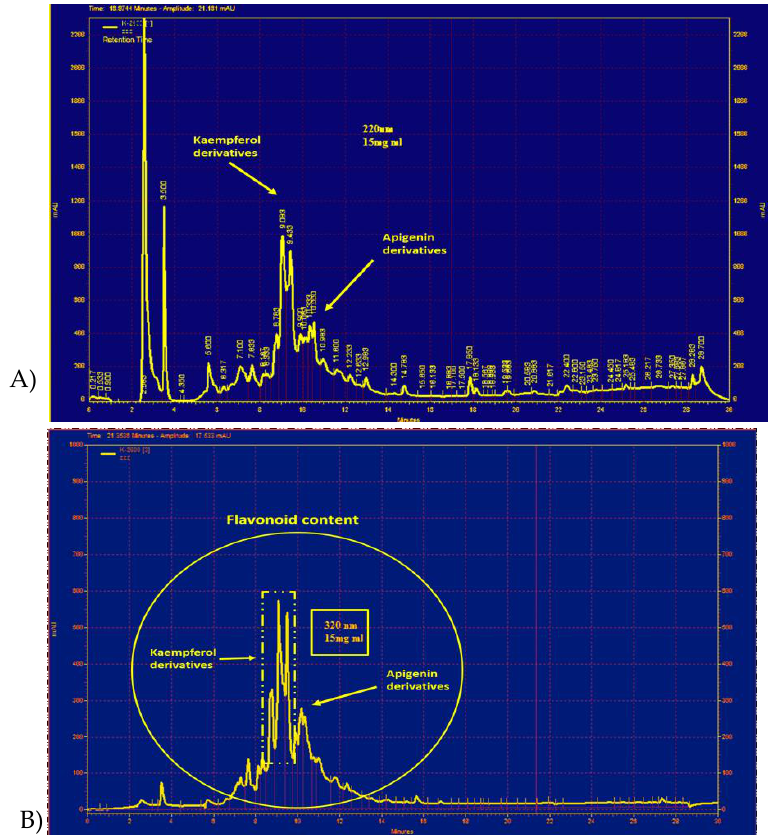
Figure 6. HPLC fingerprint of the hydro-ethanolic extract of P. oleracea at 220 nm ( A ) and 320 nm ( B ).